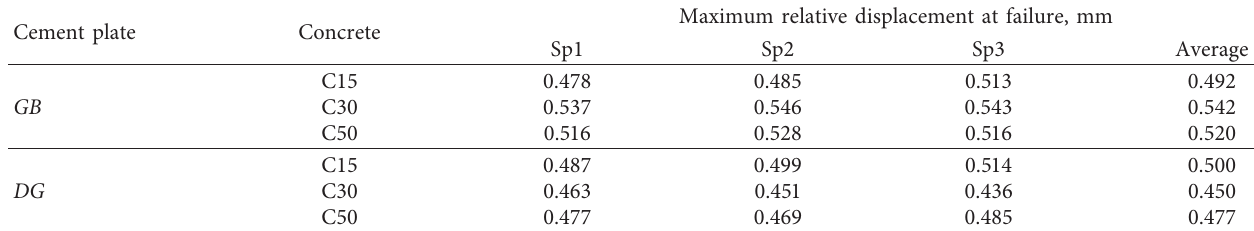
Table 7: The maximum relative bond-slip of the plate-concrete interfaces at failure for composite samples with different cement plates and concretes. Cement